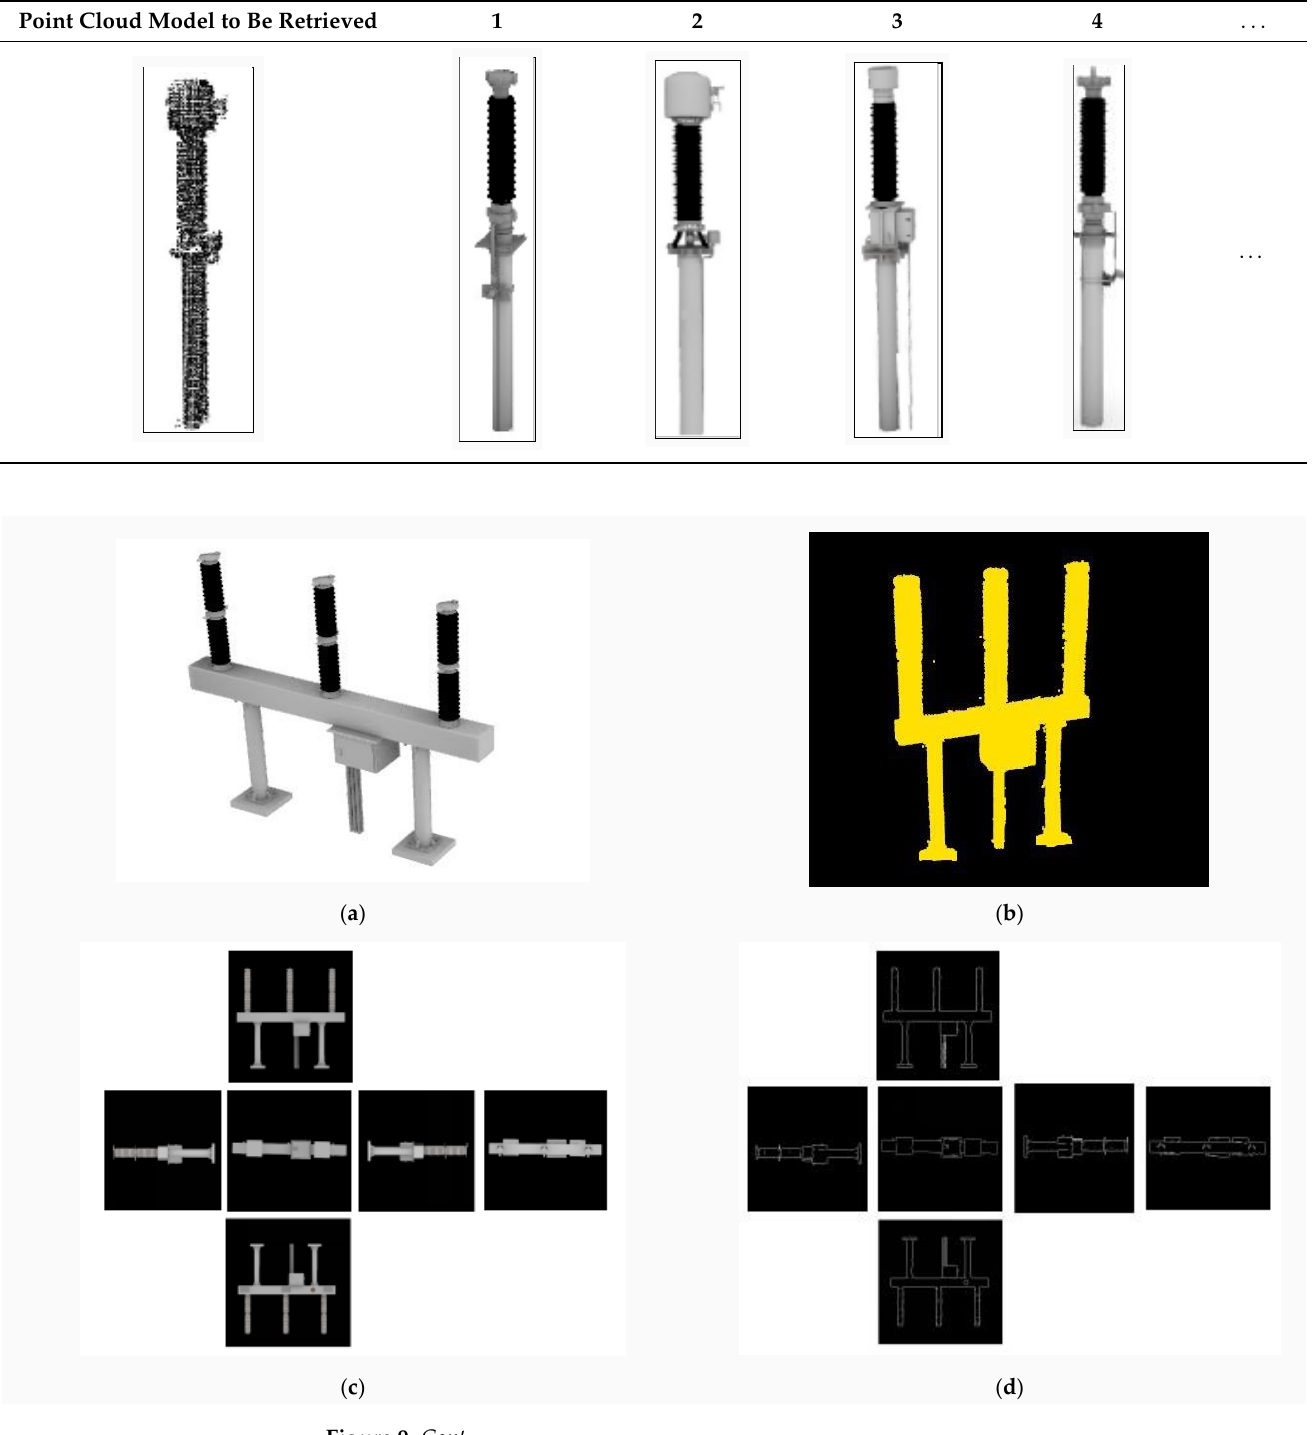
( f ) Figure 9. Edge feature of Canny. ( a ) The 3D CAD model of the voltage transformer; ( b ) 3D point cloud model of the voltage transformer. ( c ) Projected view of the voltage transformer; ( d ) edge ex- traction diagram of the voltage transformer; ( e ) point cloud projection view of the voltage trans- former; ( f ) edge extraction of the Pt point cloud. Table 3. The algorithm proposed in this paper, the D2 algorithm, and the model screening results of the two-dimensional image proposed by Shih et al. [16]. Point Cloud Model to Be Re- trieved Algorithm